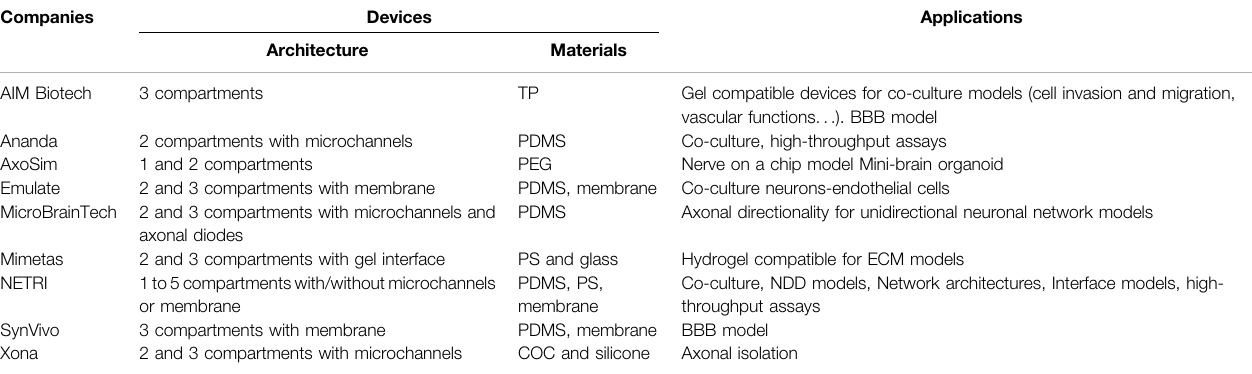
TABLE 2 | Micro fl uidic devices providers with the different materials used for manufacturing.